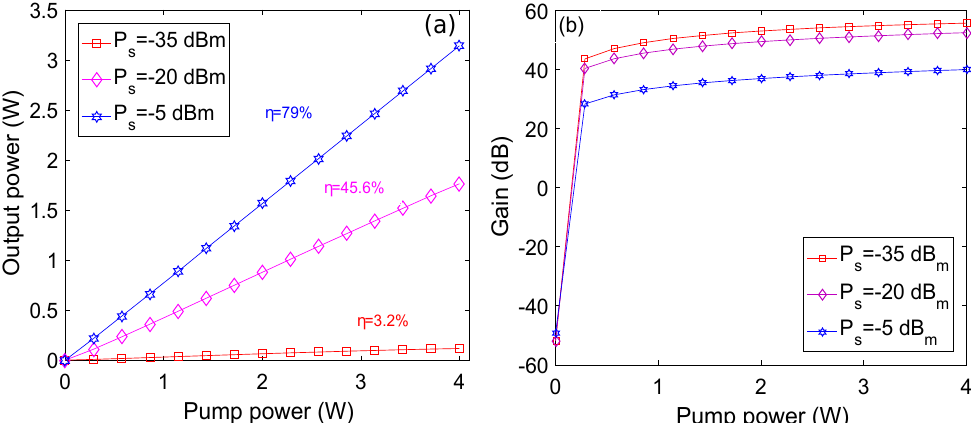
Figure 4. ( a ) Output power and ( b ) Gain of the amplifier plotted against variations of Pump power for different values of signal